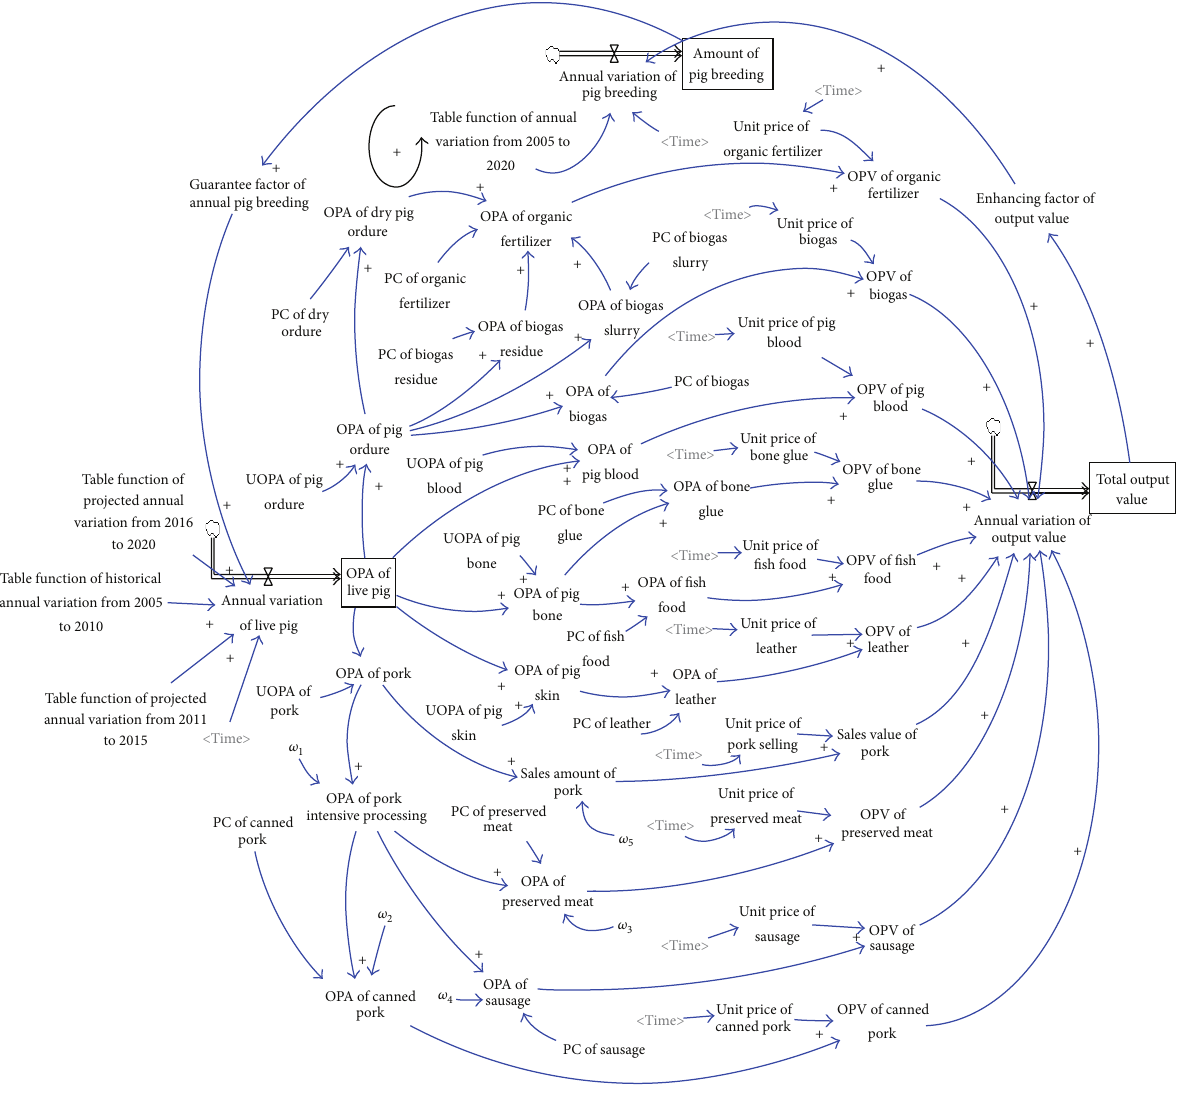
Figure 2: The output value of the pig industry